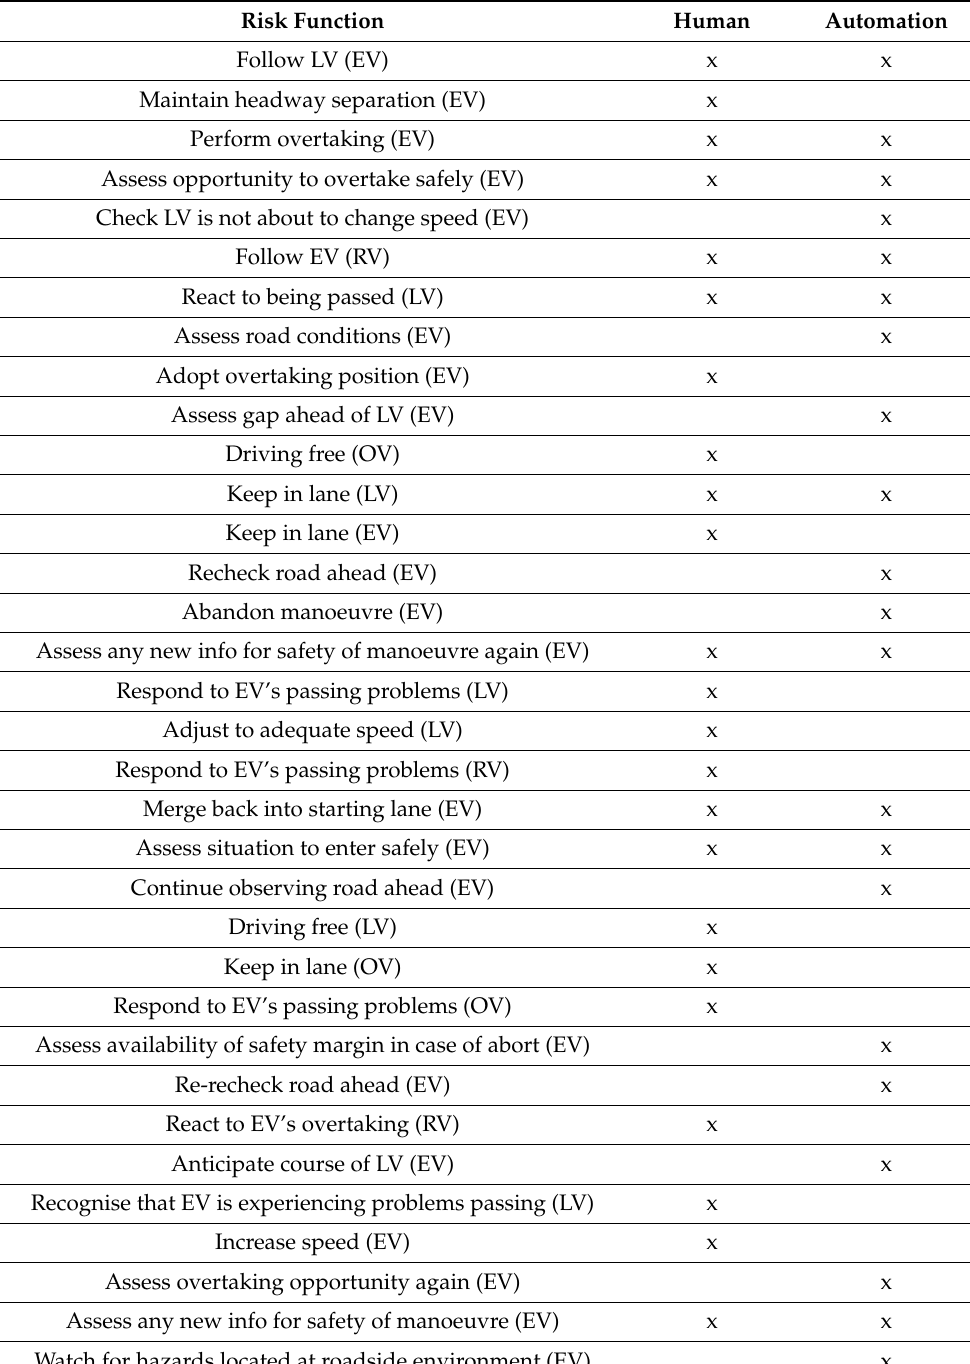
Table A4. Risk functions for human driver and